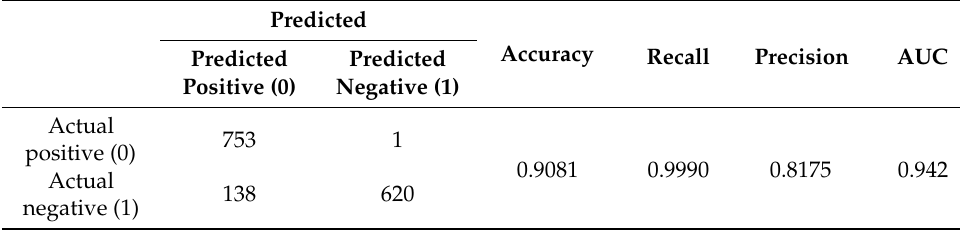
Table 5. SVM confusion matrix before segmentation.